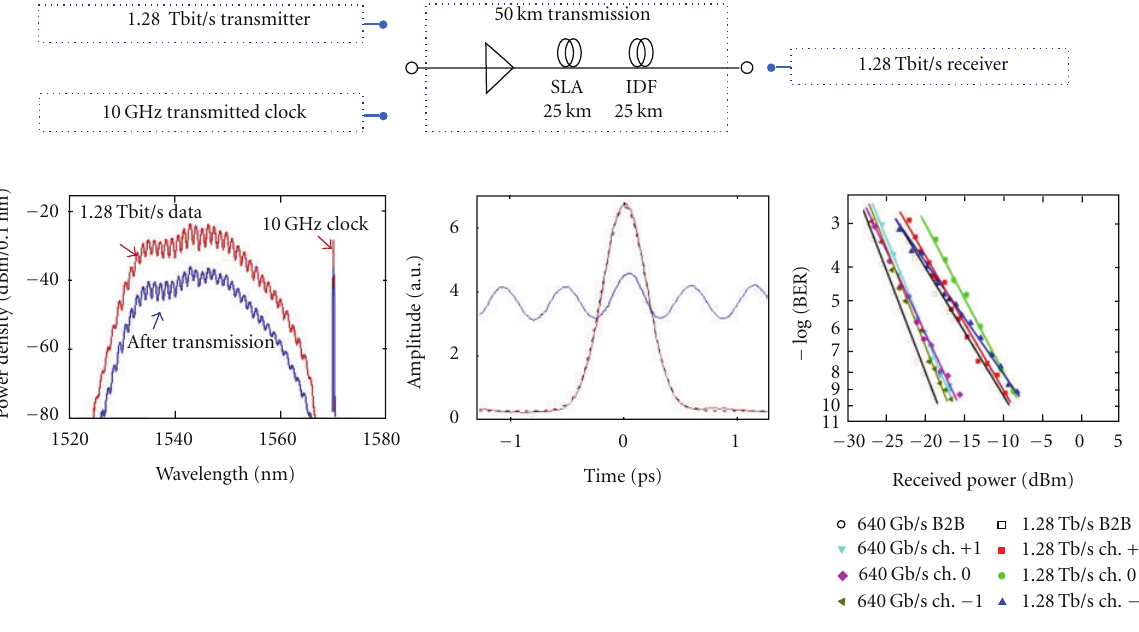
Figure 10: 1.28 Tbit/s DPSK transmission over 50 km SLA-IDF using an L-band 10 GHz transmitted clock